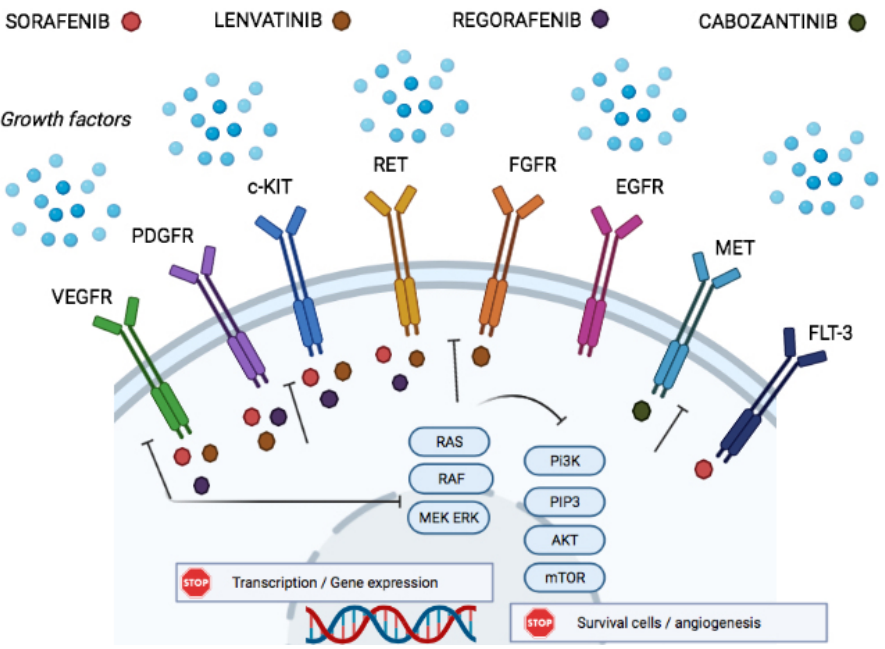
Figure 1. Tyrosine kinase inhibitors and molecular pathways in hepatocellular carcinoma .